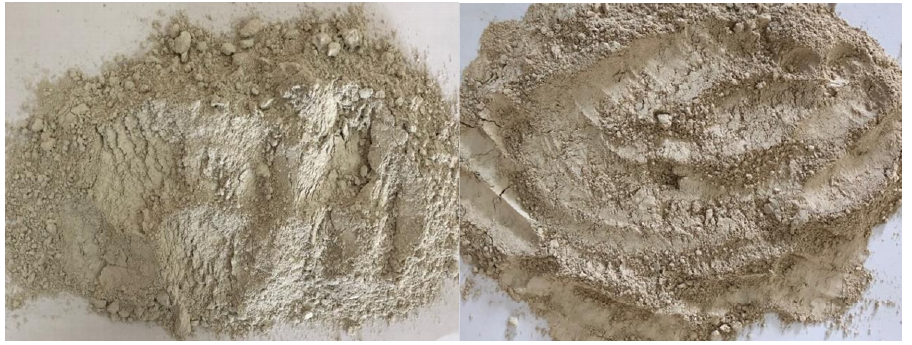
Figure 1. Appearance of the initial and treated marl.